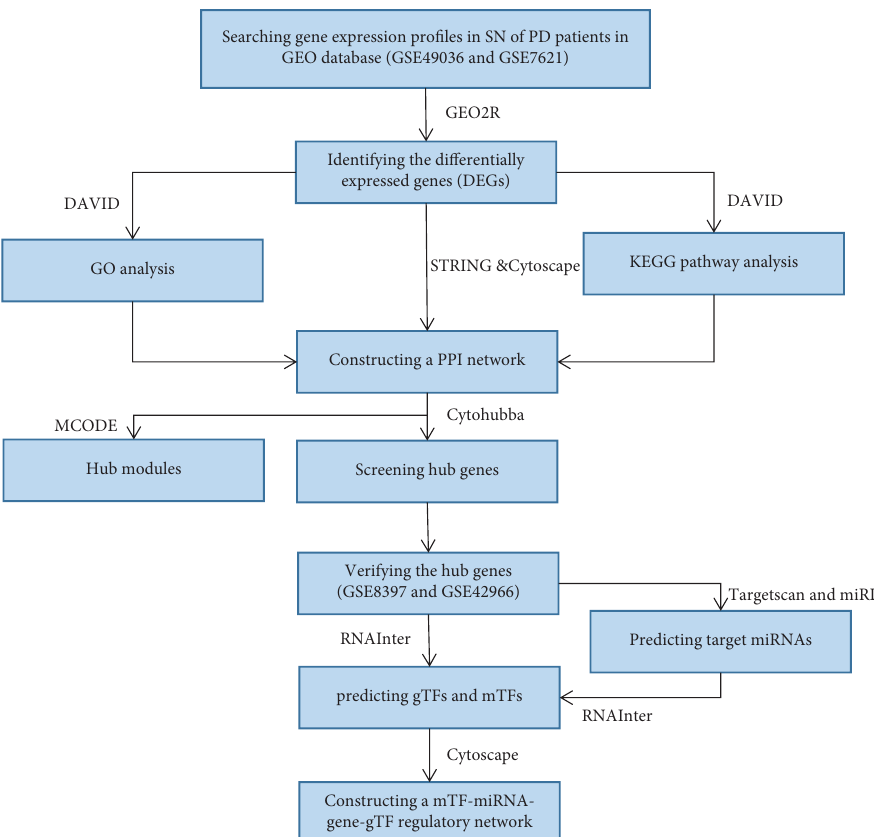
Figure 1: Te concise diagram of